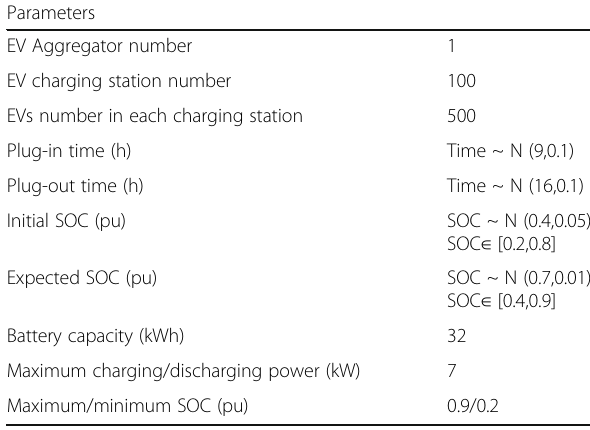
Table 2 Simulation parameters of